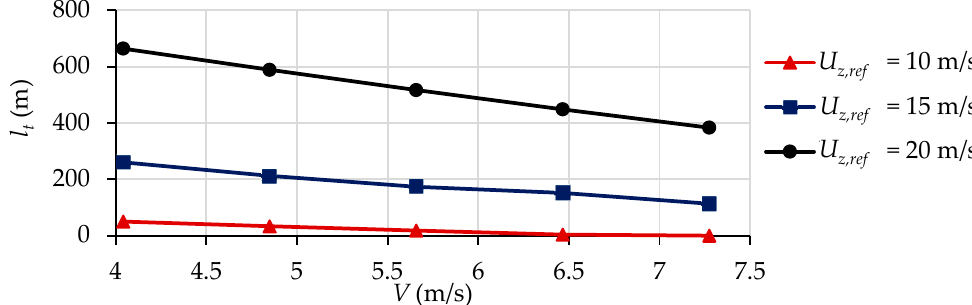
Figure 16. The optimal tether lengths for different wind and ship speeds and a kite area of 320 m 2 . The variation in the tension at the end of the tether, 𝑇 (cid:3047) , with 𝑉 for optimal perfor- mance is depicted for the three reference wind speeds in Figure 17. The value of 𝑇 (cid:3047)